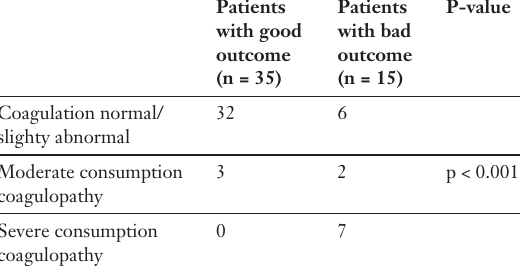
Admission coagula- tion data (n = 50).